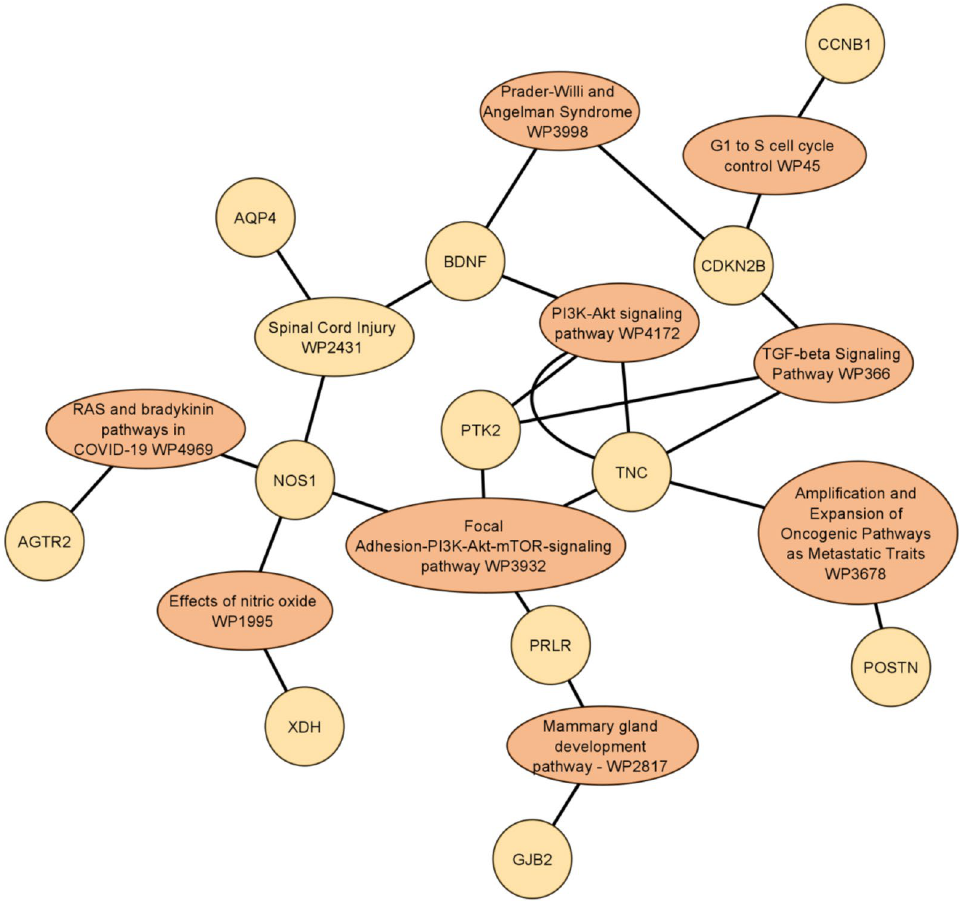
Figure 10. Network visualization of the cell signaling pathway with overlapping genes for the GDS3257 dataset using the cytoscape